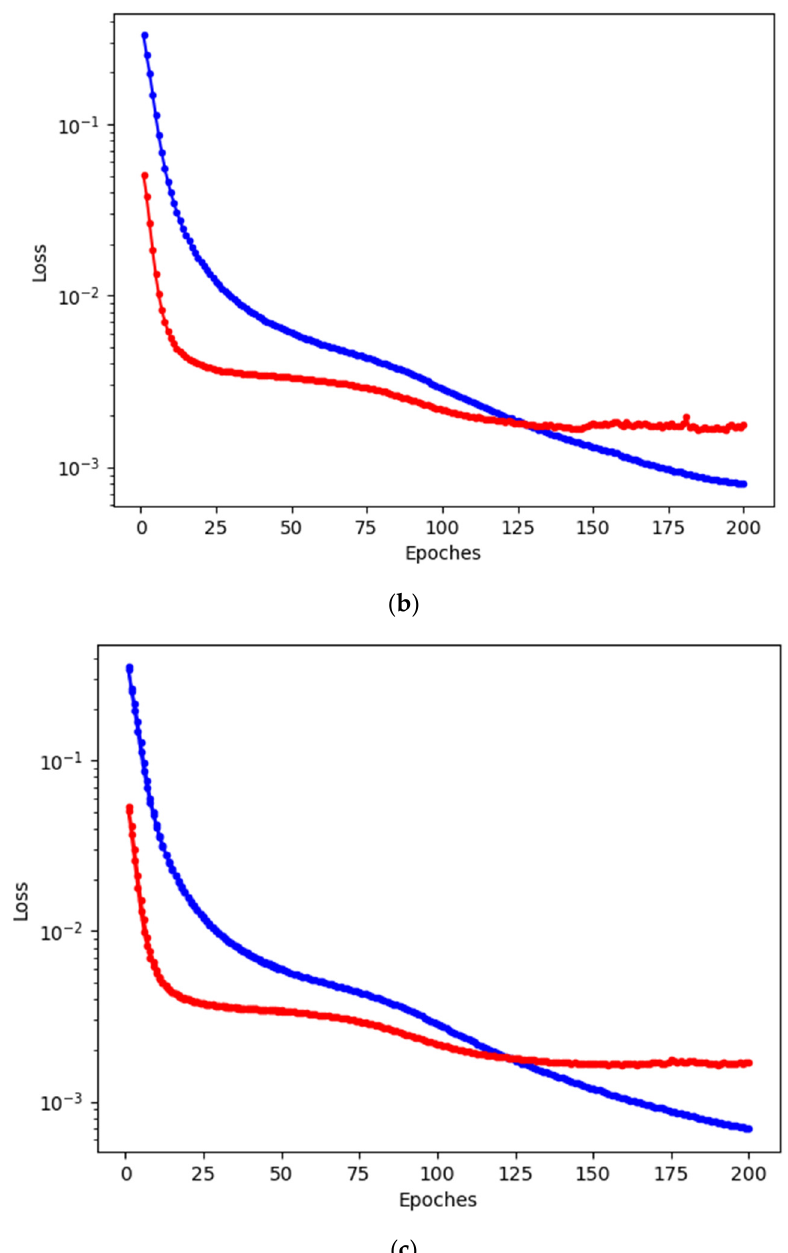
Figure 10. The loss curve of ( a ) the ConvNet, ( b ) the ResNet, and ( c ) the DRSN for MT noise suppression. The red loss curve is the loss of validation datasets, and the blue loss curve is the loss of training datasets.